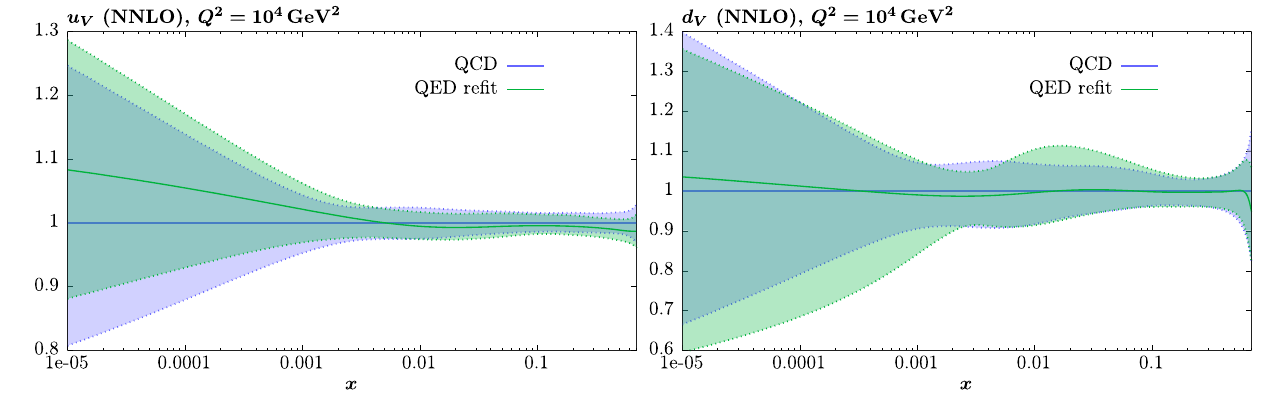
Fig. 3 The ratio of the u V and d V distributions (with uncertainties) at Q 2 = 10 4 GeV 2 , resulting from NNLO fits to the MSHT20 dataset, with QED effects included to that without